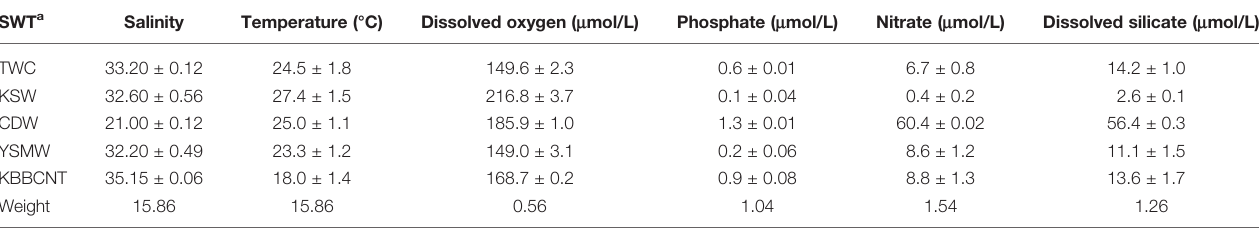
TABLE 1 | Source water type (SWT) de fi nitions for the Taiwan Warm Current (TWC), Kuroshio Surface Water (KSW), Changjiang Diluted Water (CDW), Yellow Sea Mixed Water (YSMW), Kuroshio Bottom Branch Current North of Taiwan (KBBCNT), and parameter weights used in the optimum multiparameter analysis for this study. SWT a Salinity Temperature (°C) Dissolved oxygen ( m mol/L) Phosphate ( m mol/L) Nitrate ( m mol/L) Dissolved silicate ( m